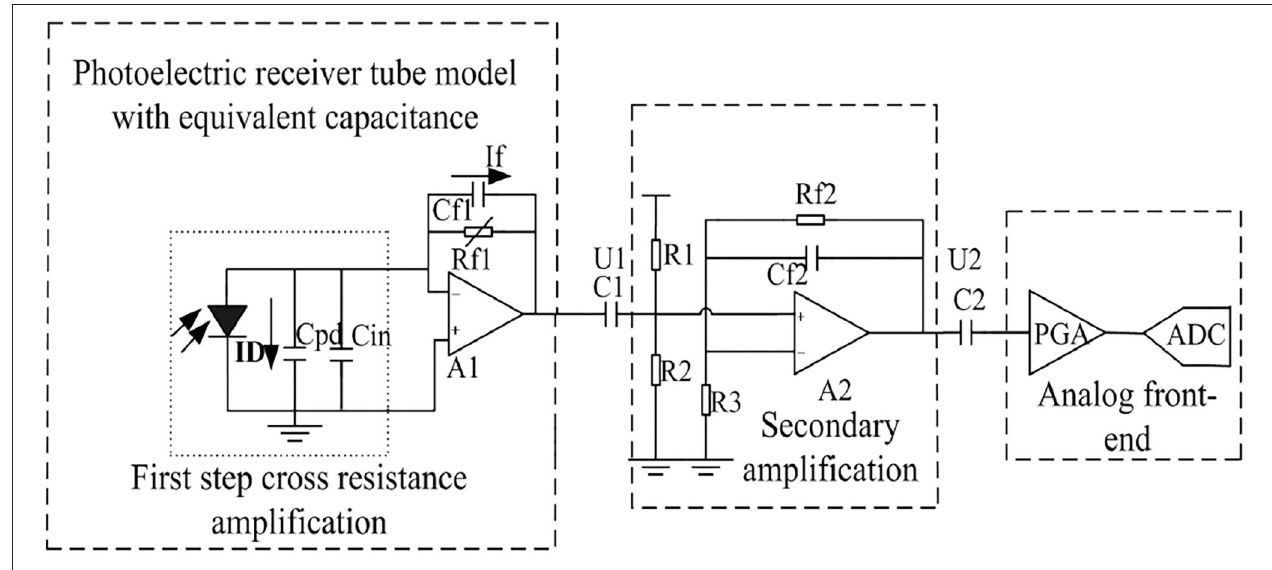
FIGURE 4 | Preprocessed circuit including three-stage amplification.